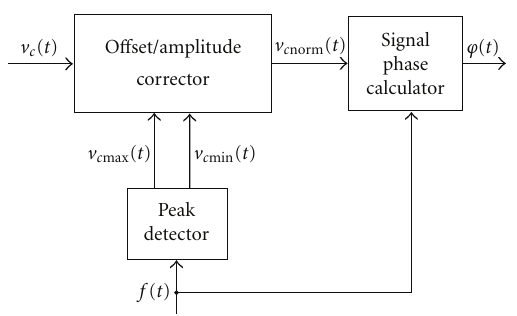
Figure 1: Block diagram of signal-phase meter macromodel.